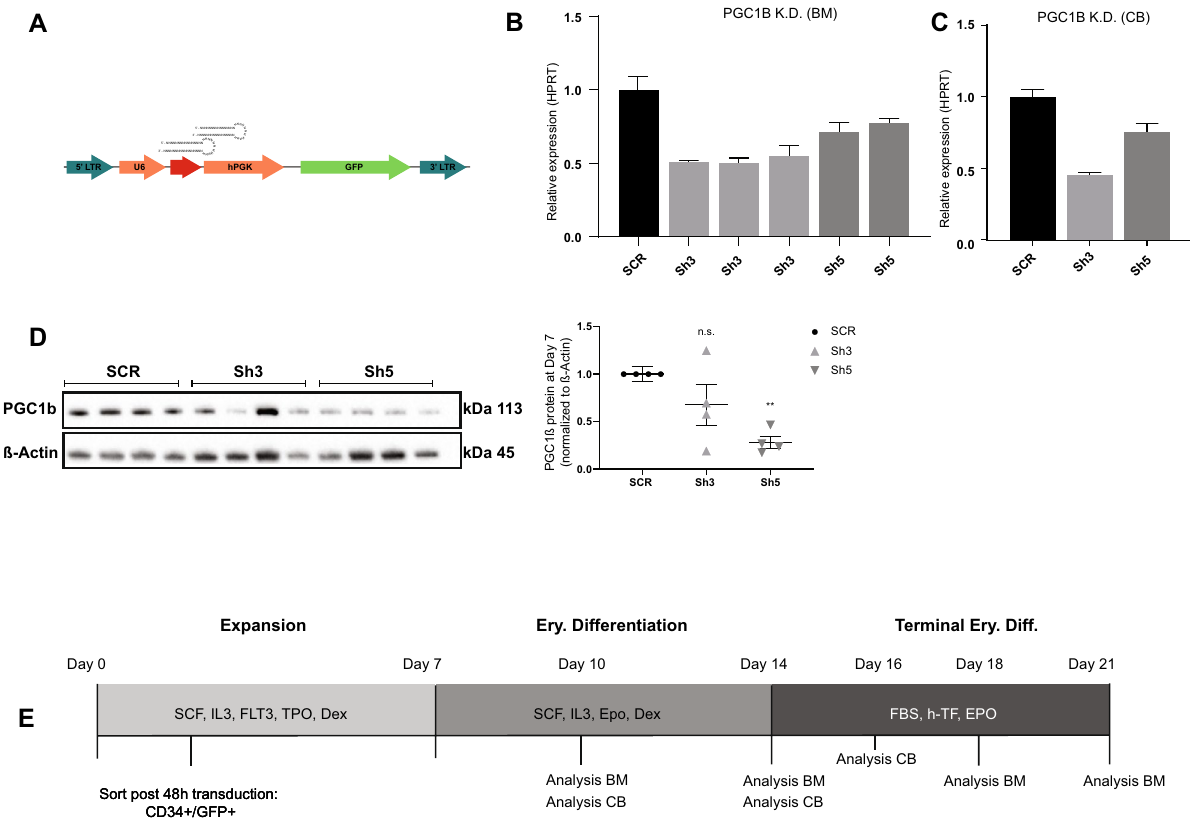
Figure 1. Experimental setup to study perturbed PGC1β signaling during human erythroid development. ( A ) Description of the pLKO lentiviral vector used, expressing a scrambled control vector (Scr) or two different short hairpin RNA for PGC1β, sh3 and sh5. Initial transduction efficiency was on average 65% on day3 (SCR: 62%, sh3: 66%, sh5 66%). ( B ) Quantification of knock-down efficiency in transduced cells at the transcriptional level in B) bone marrow derived CD34 + cells and ( C ) cord blood derived CD34 + cells. (n = SCR:4, Sh3:12, Sh5:6 for BM and n = 4 for CB). ( D ) Knock-down efficiency of PGCβ at the protein level in cord blood derived progenitors on day7 as assessed by western blot. Quantification of PGC1β protein was normalized to ß-ACTIN. ( E ) Schematic outline of the 3-phase erythroid culturing system of human CD34 + cells (modified from Hu et al. 2013) 32 . 25,000 transduced CD34 + BM cells or 100,000 transduced CD34 + CB cells were seeded on day 3, and split on days of medium switching, with average cell concentrations of 9 × 10 5 cells/ml, 3.5 × 10 6 cells/ml and 2 × 10 5 cells/ml on days 14, 18 and 21 respectively. Data is presented as mean ± SEM (*P ≤ 0.05, **P ≤ 0.01, ***P ≤